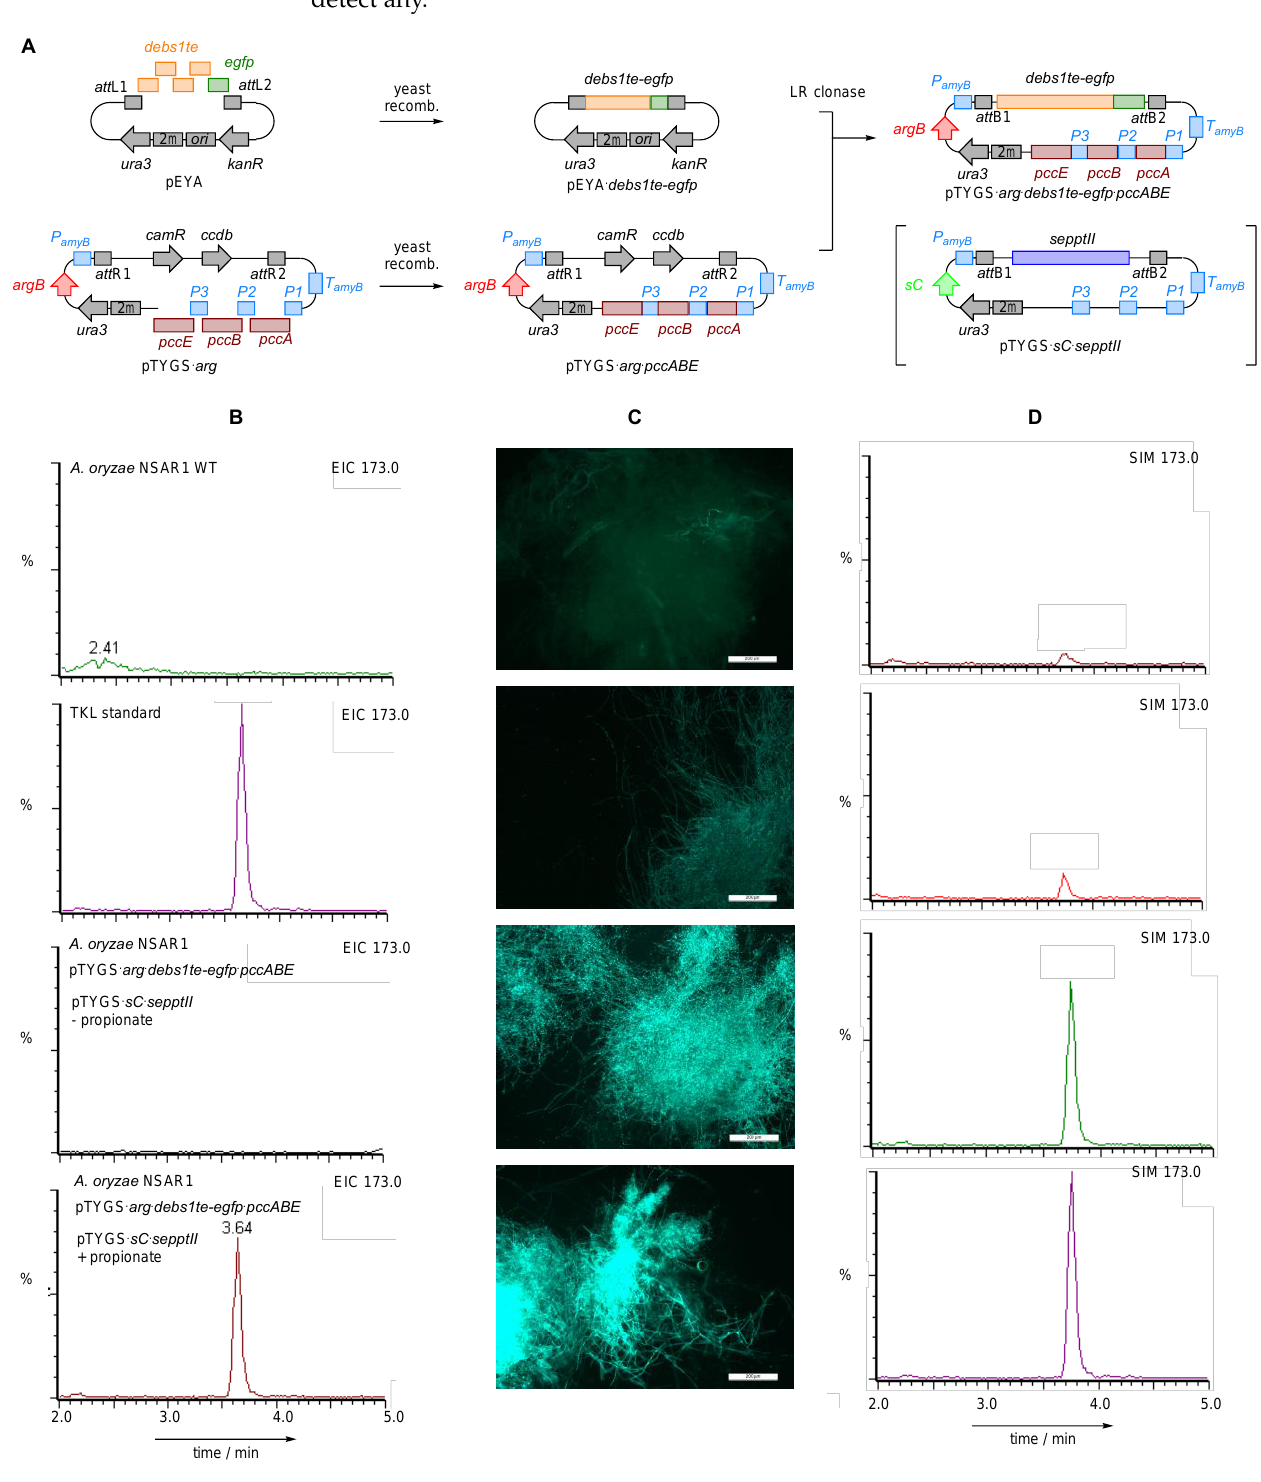
Figure 4. Construction of functional modular PKS in A. oryzae . ( A ) Construction of vectors; ( B ) LCMS analysis of A. oryzae NSAR1, standard TKL, and transformants in the absence and presence of propionate as indicated ES+ at m/z 173.0; ( C ) microscopic images of four A. oryzae NSAR1 transformants showing variability of eGFP intensity; ( D ) quantitative selective ion monitoring (SIM, ES+ at m/z 173.0) of extracts of the corresponding A. oryzae strains shown in panel C. Scale bars 200 μ m.